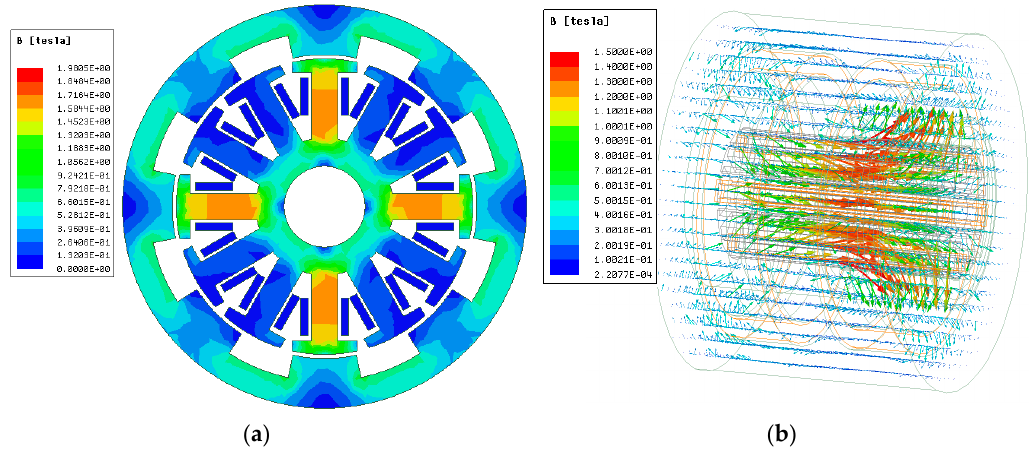
Figure 4. The flux distribution of the motor for. ( a ) the rotational movement section view and ( b ) the linear movement section view.